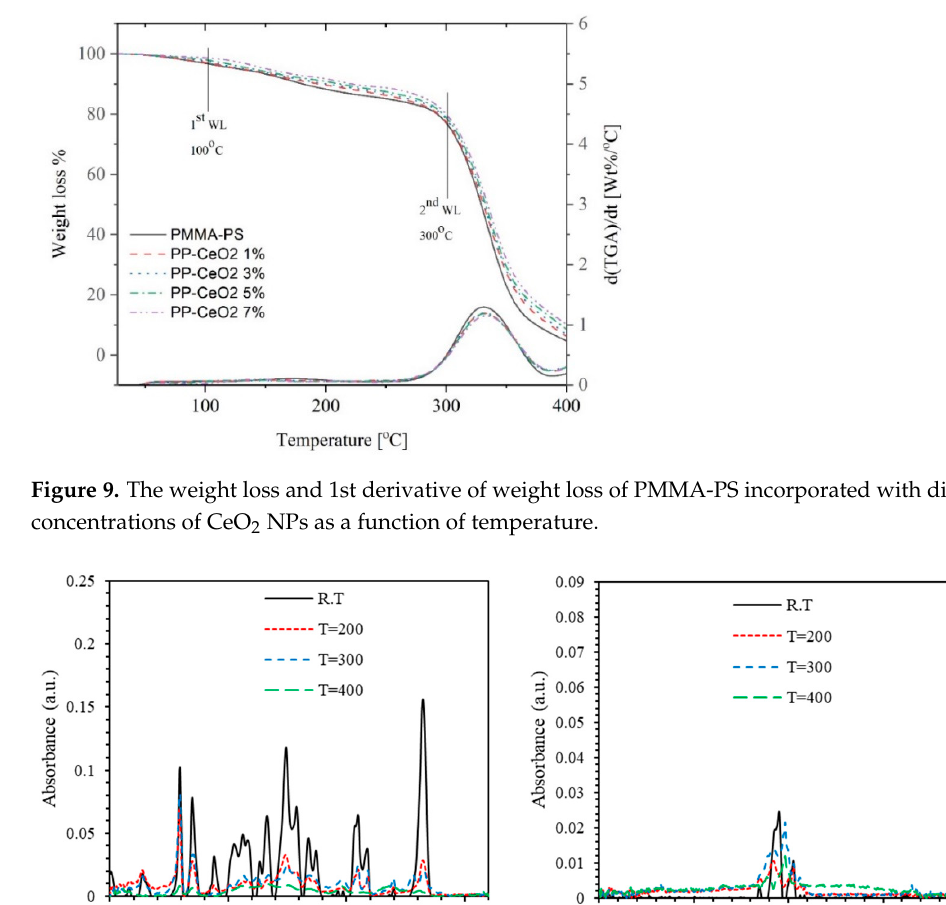
Figure 10. The absorbance of PMMA-PS processed at different annealing temperatures.